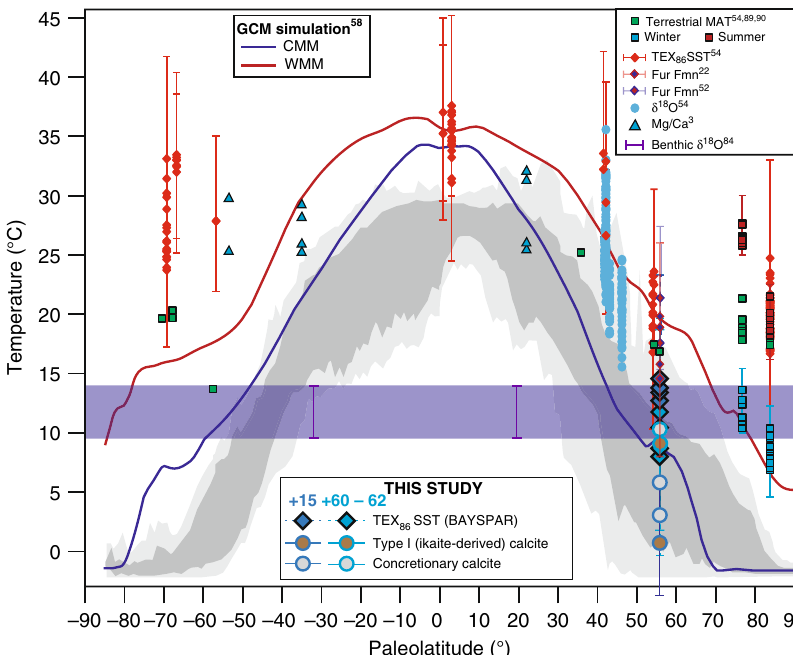
Fig. 7 Compilation of early Eocene global temperature estimates. This spans the interval between PETM and ETM2/EECO (55 – 54 Ma 85 ). New Δ 47 bottom water temperatures and biomarker-derived terrestrial mean annual temperatures (MBT ’ /CBT, using the calibration of Peterse et al. 88 ), foraminiferal δ 18 O temperatures, and TEX 86 SSTs (recalibrated using BAYSPAR 31 as compiled by Hollis et al. 54 . TEX 86 SSTs from Stokke et al. 22 show data from between ash horizons − 13 and + 101, excluding those with BIT > 0.4 and Δ RI > ± 0.3. Summer and winter terrestrial temperatures by bioclimatic analysis from Lomonosov Ridge 89 , and from Russia 90 . Reevaluated Mg/Ca data from the compilation of Evans et al. 3 . Error bars for biomarker and clumped isotope temperature reconstructions (both published and this study) denote the 95% con fi dence level. GCM simulations for EECO from Davies et al. 59 show modelled mean SSTs for warm and cold months (red and blue lines, respectively), from the HadCM3L model, at 1200 ppm CO 2 . Modern mean annual temperature and seasonal range in SST 3 are shown (dark- and light-grey shading, respectively). Bottom water temperature ranges from benthic foraminifera shown in blue shading 55 . CMM cold month mean, WMM warm month